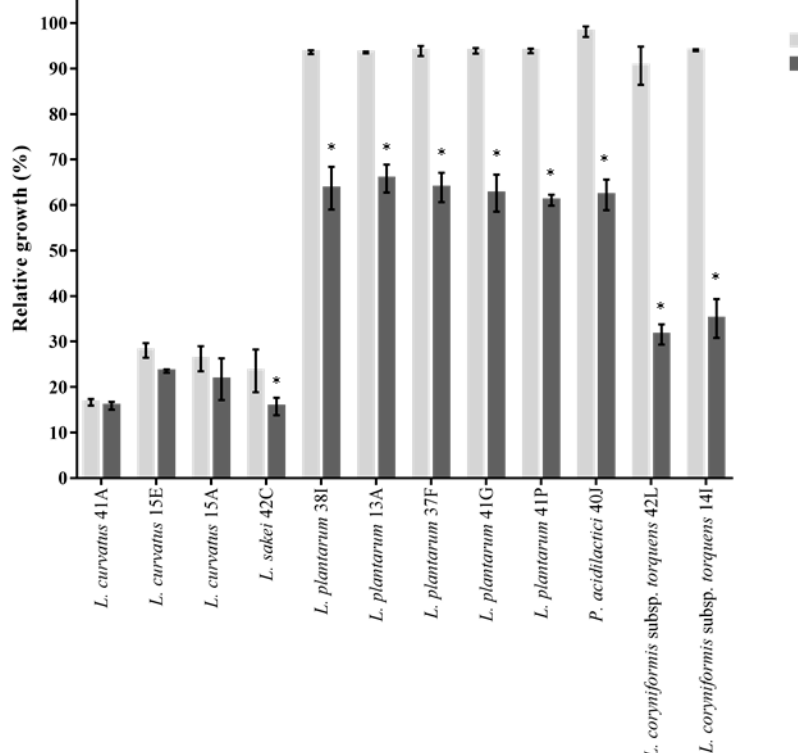
Figure 4. Effect of phenol on the growth of LAB isolates. Asterix (*) showed significantly different ( p < 0.05) mean ± SD (of three independent experiments) compared to lower phenol concentration (0.2%).